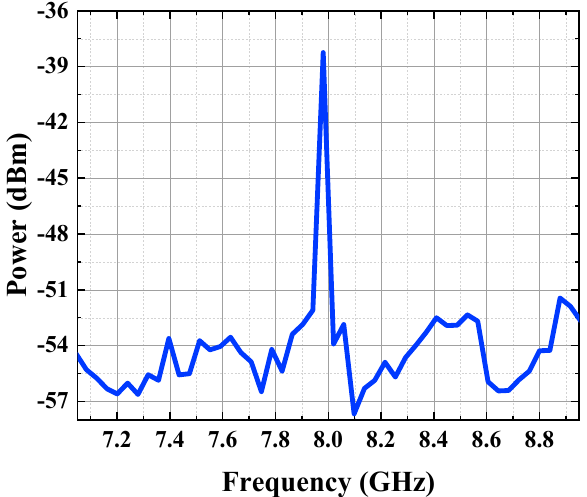
Figure 4. Electrical spectrum of the microwave frequency divider.